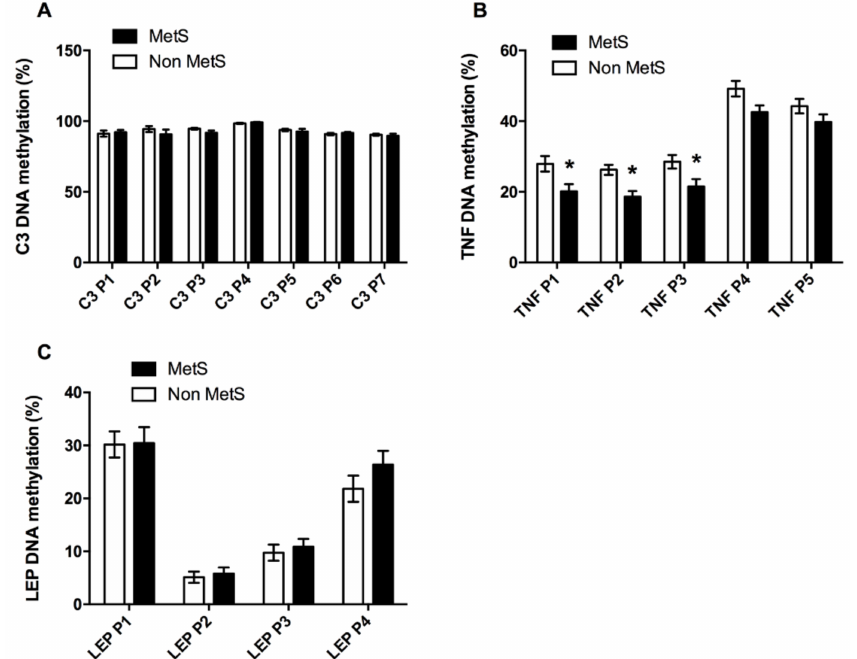
Figure 4. Inflammatory promoters DNA methylation. Comparisons between the Non MetS and the MetS group for DNA methylation at different CpG from genes implied in inflammatory processes as C3 ( A ), TNF ( B ) and LEP ( C ). Values are given as the mean ± SE. Complement factor 3 (C3); tumor necrosis factor (TNF); leptin (LEP). * means p < 0.05 according to a Student’s T